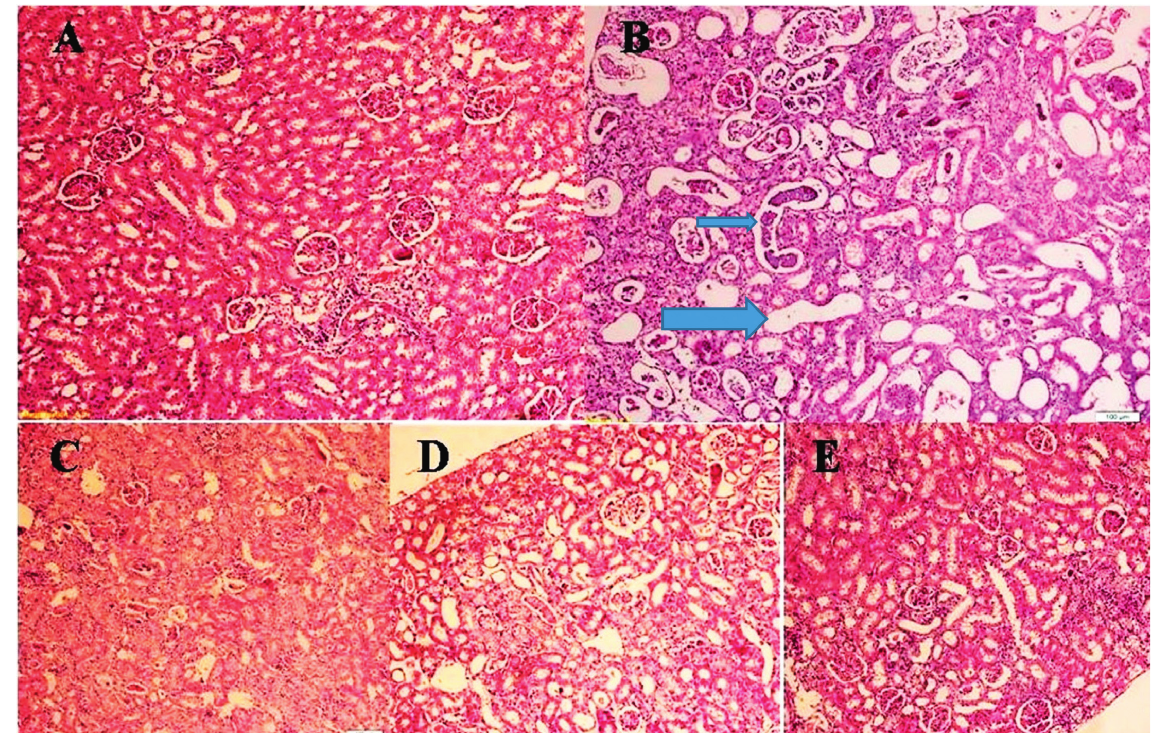
Figure 2: Photomicrograph of rat kidney stained with hematoxylin and eosin (10x). (A) Control. (B) Vancomycin (VAN) treated. (C) VAN plus 250mg/kg hydroalcoholic extract of Rosa canina . (D) VAN plus 500mg/kg hydroalcoholic extract of Rosa canina . (E) Only 500mg/kg hydroalcoholic extract of Rosa canina . In the VAN group, diffuse tubular dilatation (large arrow) and casts (small arrow) are prominent at this picture. There are also areas of necrosis and inflammation. All of these changes are less prominent or absent in VAN+RC groups in C and